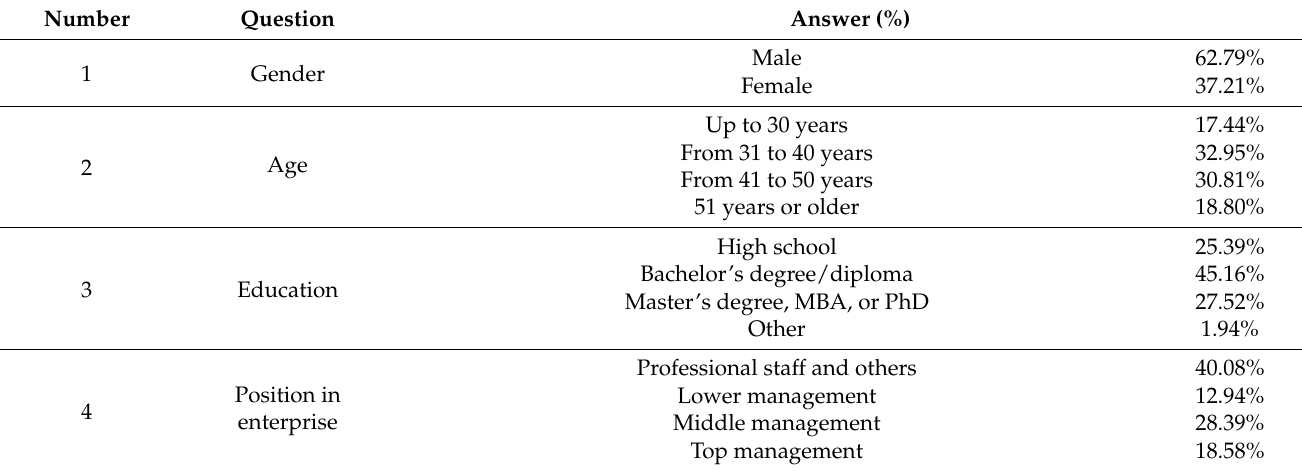
Table 1. Demographic